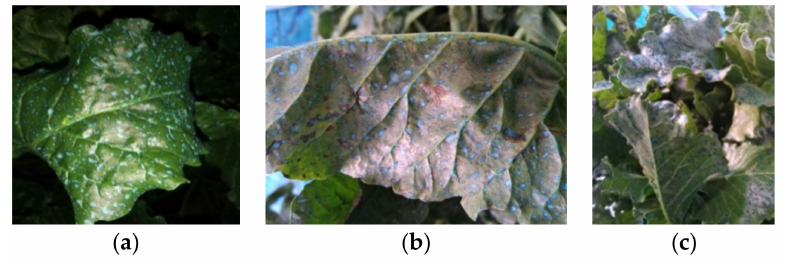
Figure 2. The upper surface of the sugar beet leaves after the treatment with fungicide in laboratory conditions with laboratory sprayer and TDADF nozzles ( a , b ) and after raining ( c